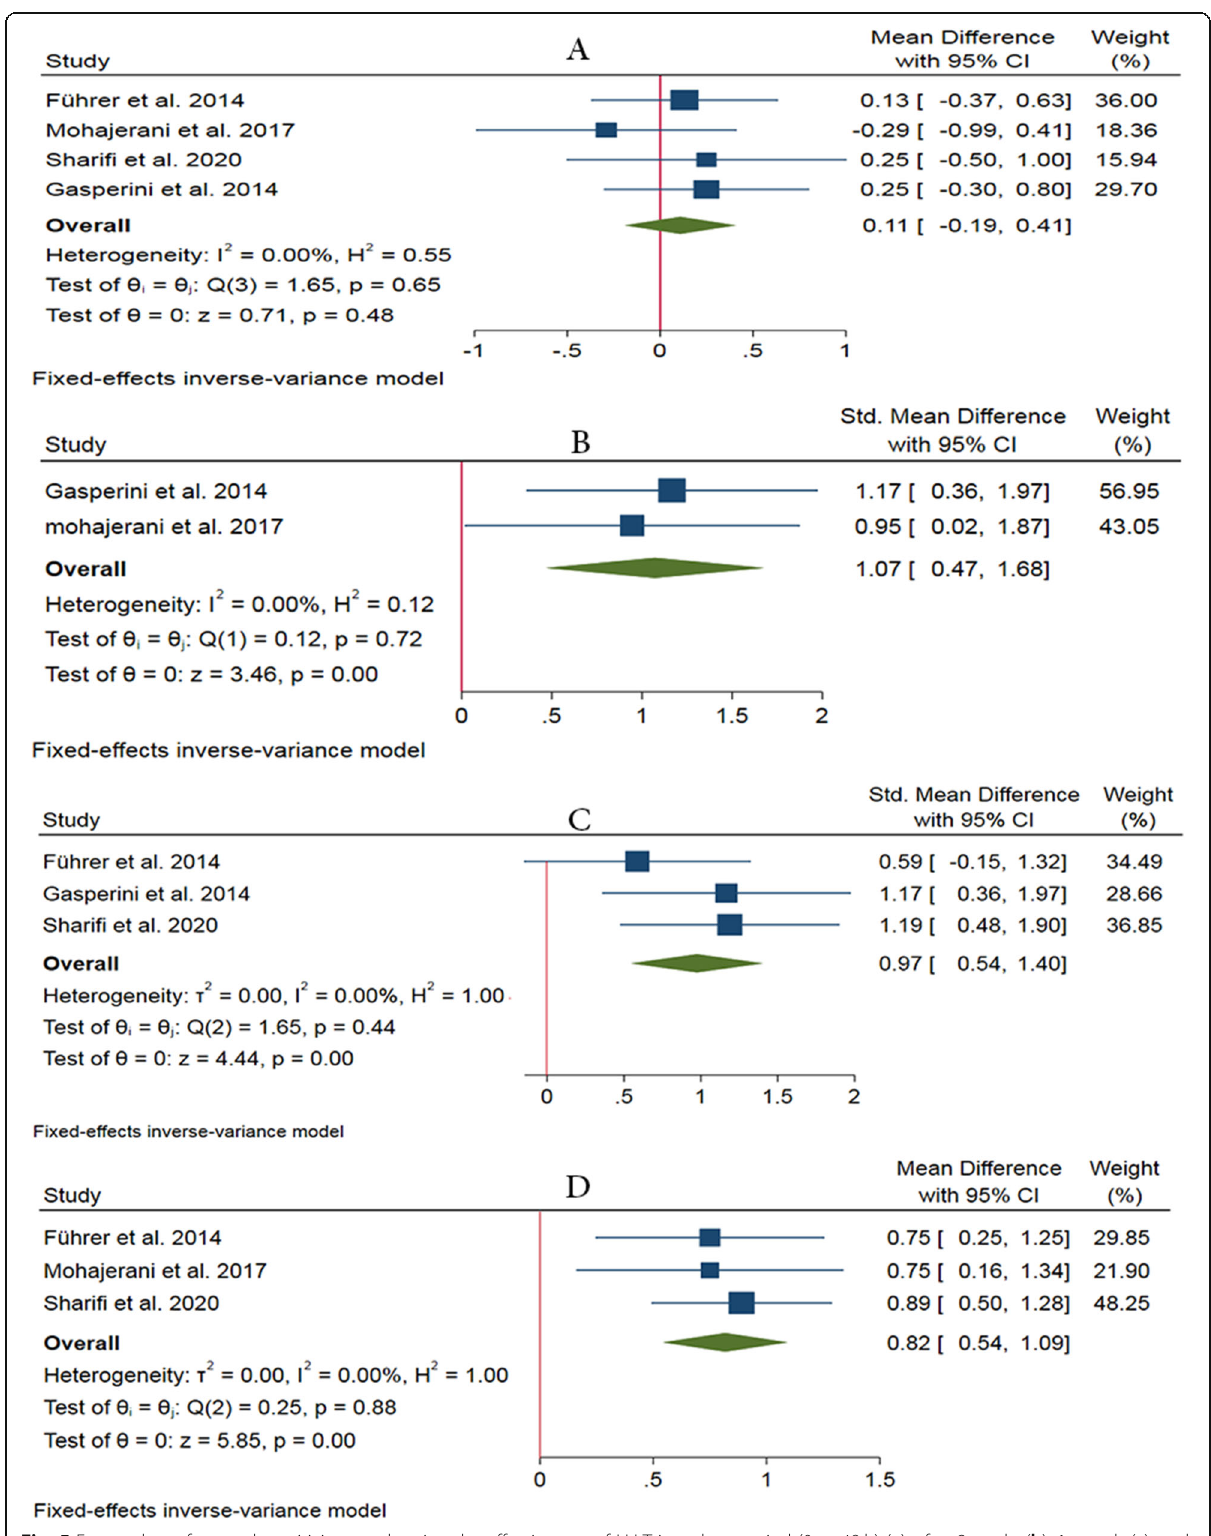
Fig. 5 Forest plots of general sensitivity test showing the effectiveness of LLLT in a short period (0 to 48 h) ( a ), after 2 weeks ( b ), 1 month ( c ), and 2 months after BSSRO ( d